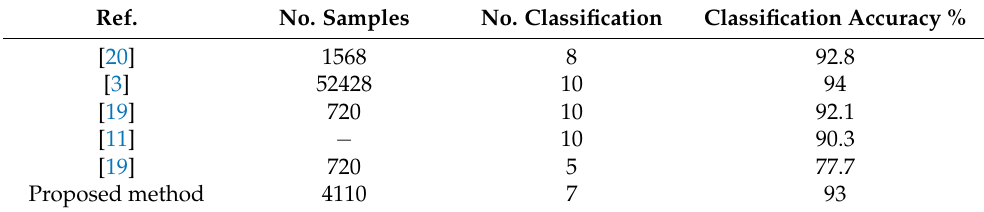
Table 8. Comparison of the different results of different references from NN classifier for PV fault detection. Ref. No.